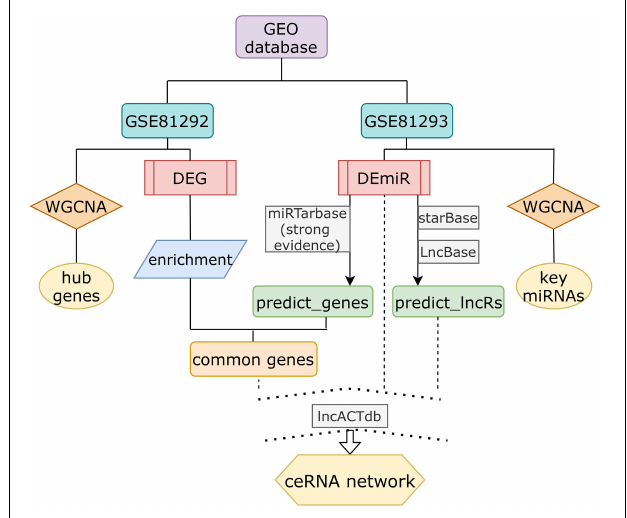
FIGURE 1 | The schematic diagram of the data analysis. DEG, differential expressed genes; DEmiRs, differential expressed